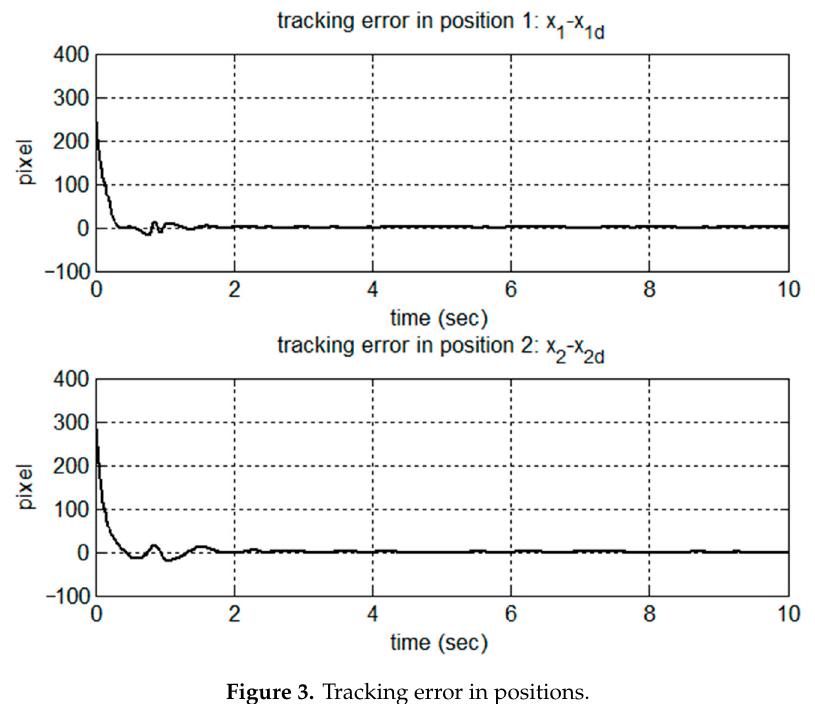
Figure 3. Tracking error in positions.